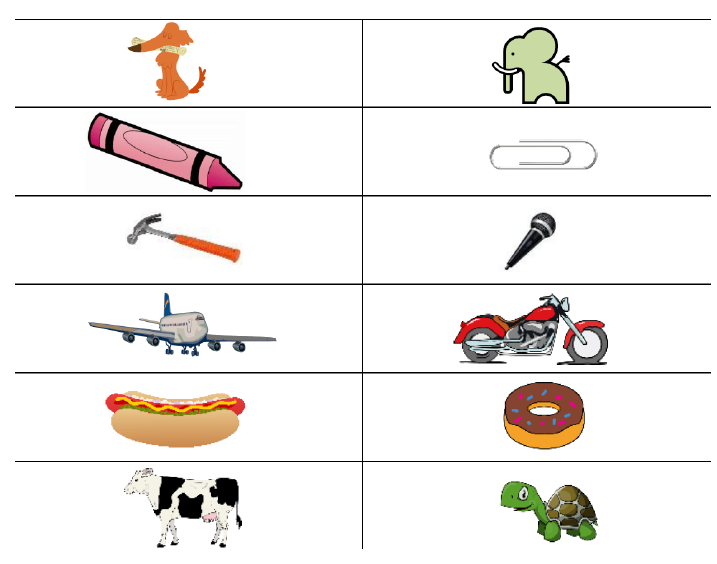
Table A1. Tests of Between-Subjects